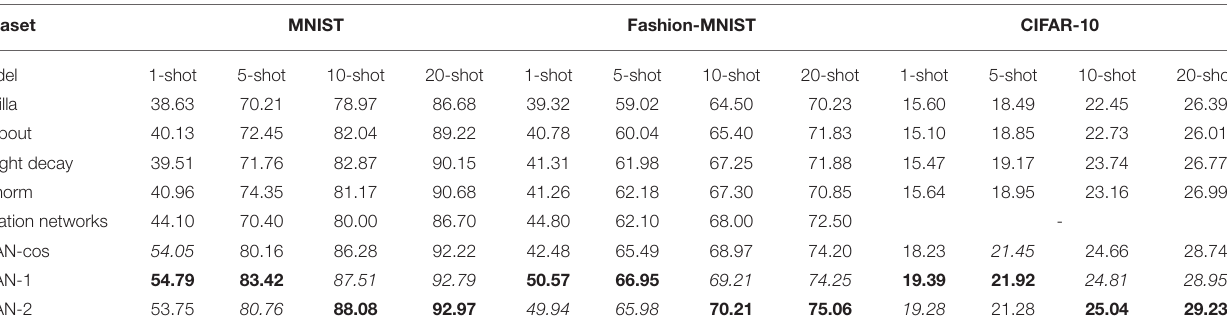
TABLE 2 | Few-shot learning from scratch experiments on the MNIST (left), Fashion-MNIST (middle), and CIFAR-10 (right) datasets. Dataset